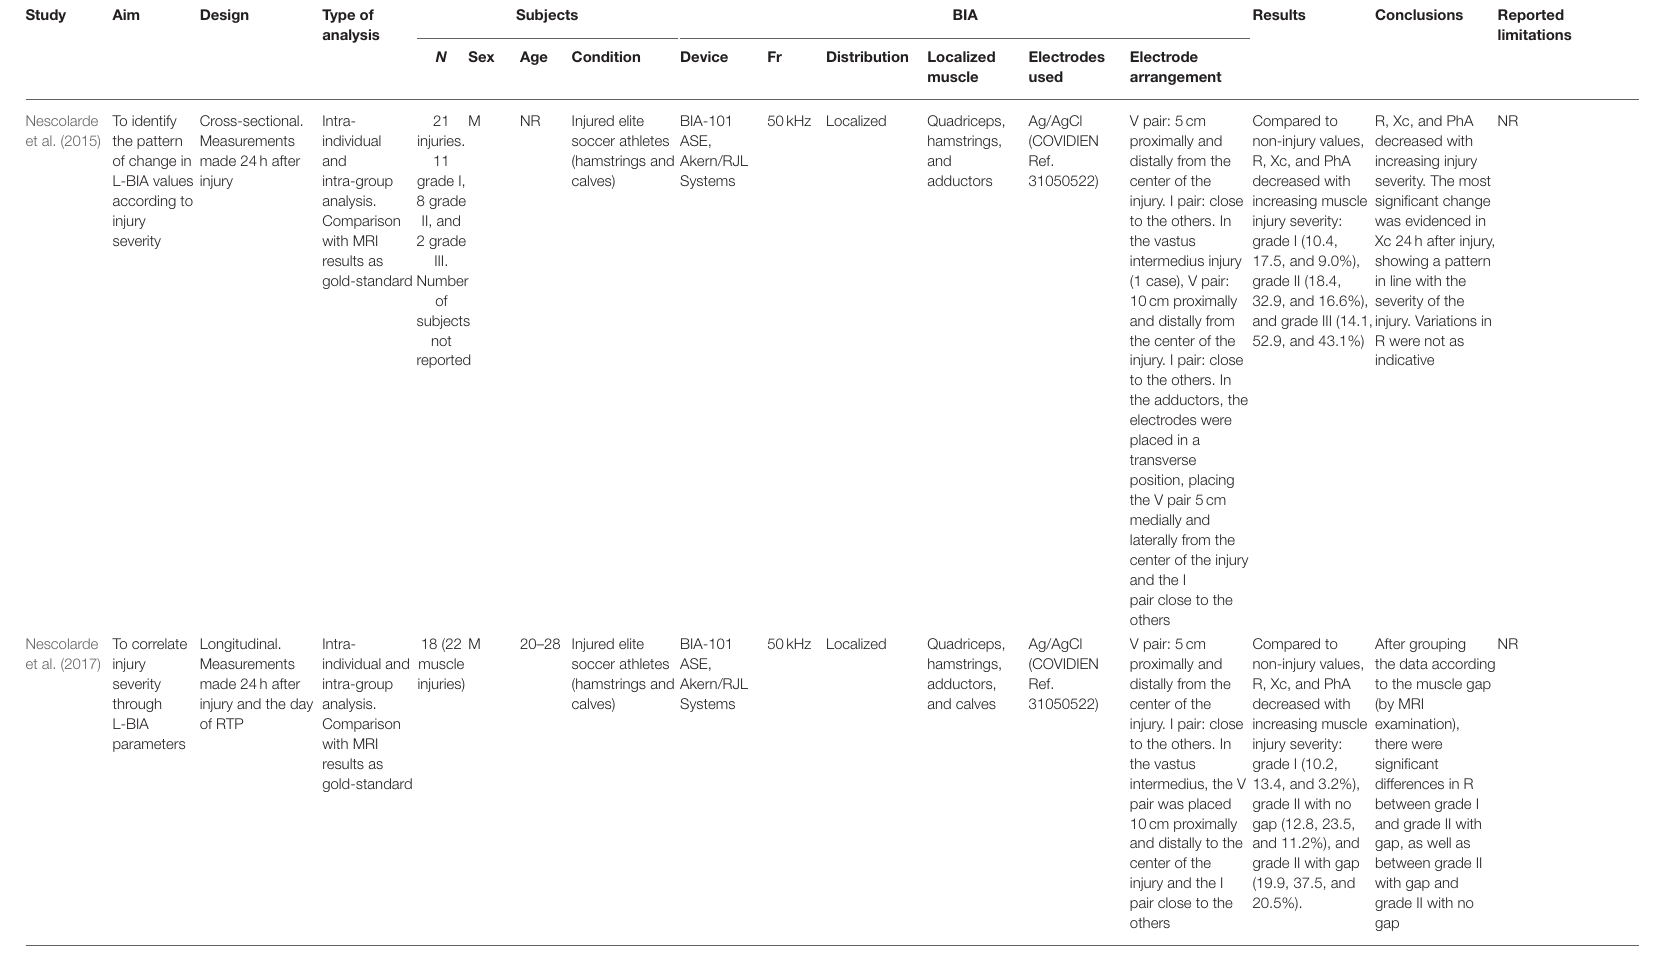
V pair: 5cm proximally and distally from the center of the